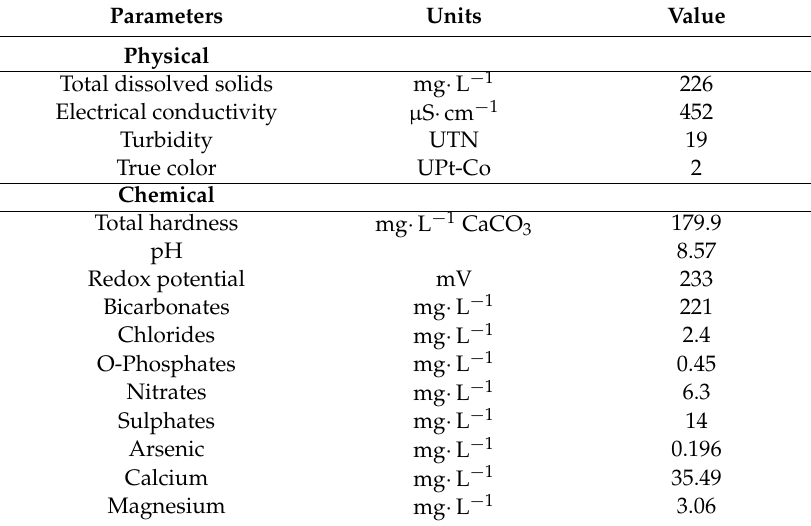
Table 1. Huautla mine shaft water